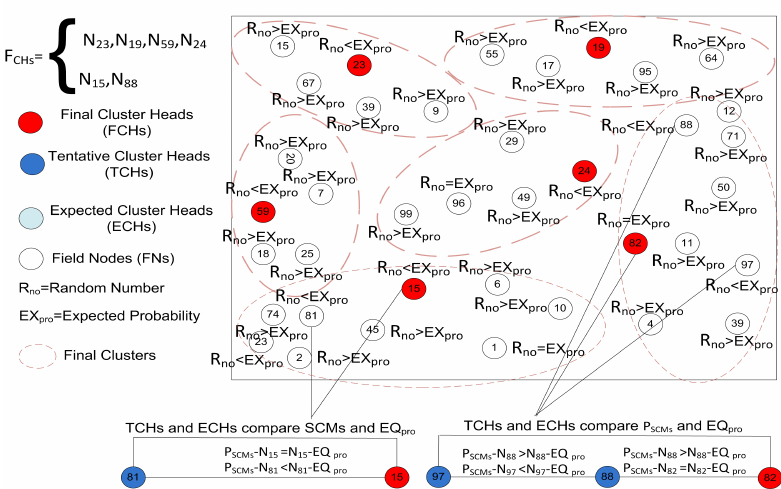
Figure 5. Finalizing the number of CHs from the TCHs and ECHs on the basis of equilibrium